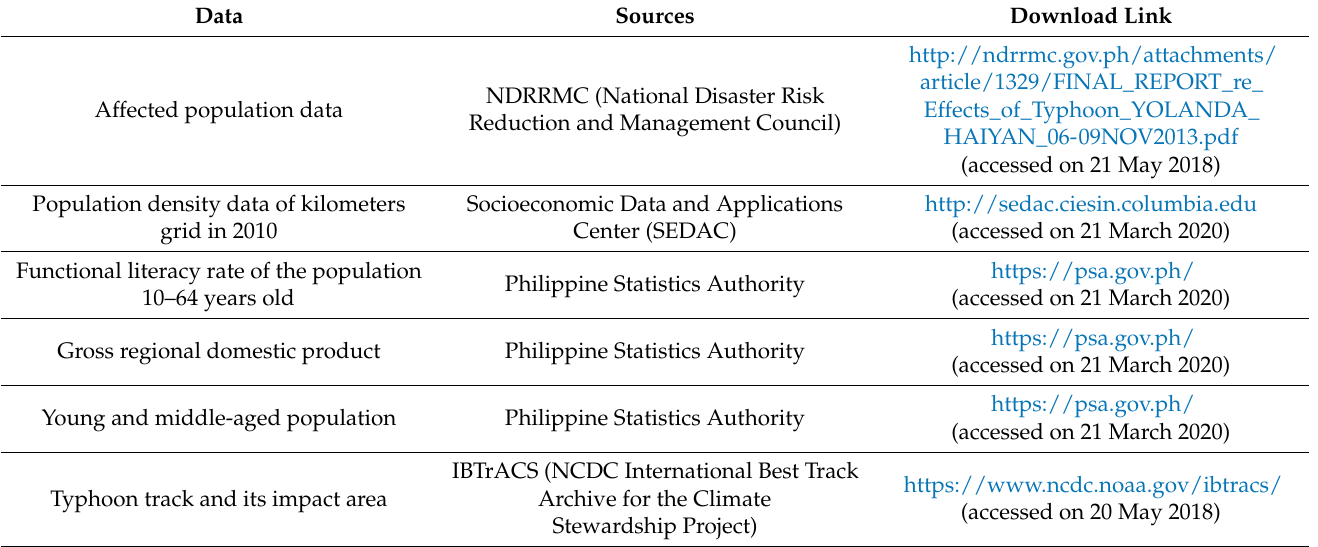
Figure 2. Research framework and workflow describing tweet selection, sentiment analysis, and temporal and spatial analyses. Table 1. Data sources and download